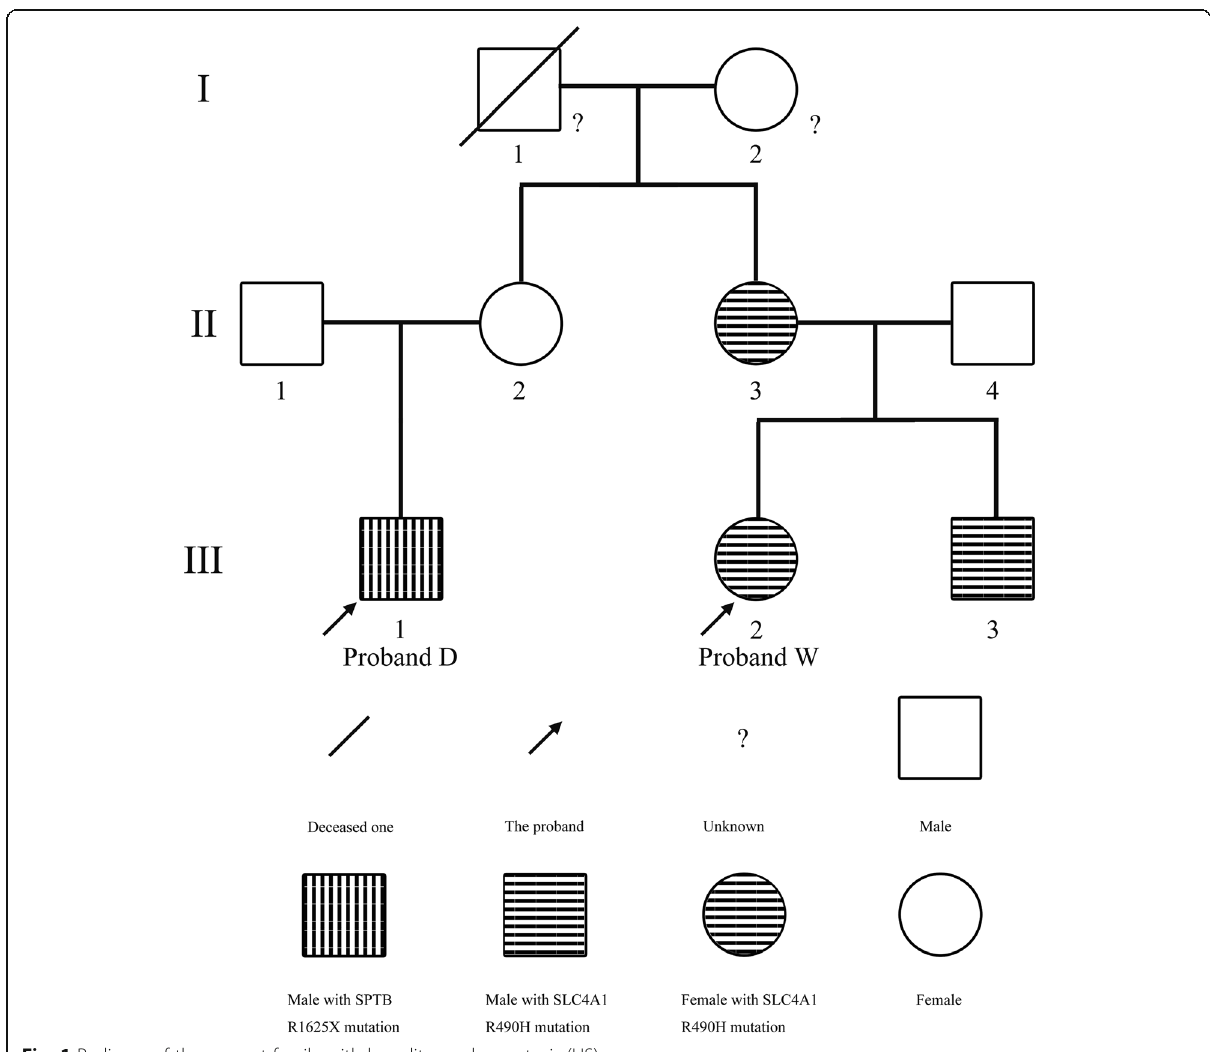
Fig. 1 Pedigree of the present family with hereditary spherocytosis (HS)